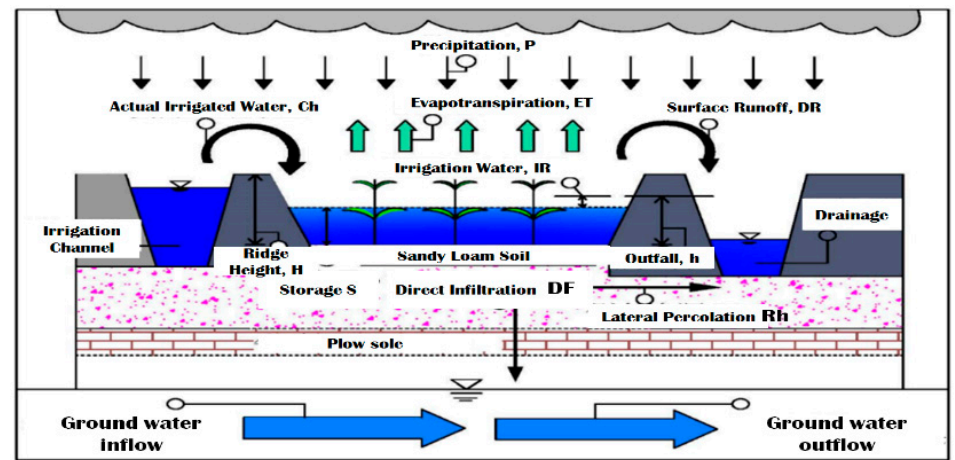
Figure 3. The conceptual model used to develop water balance approach [1].